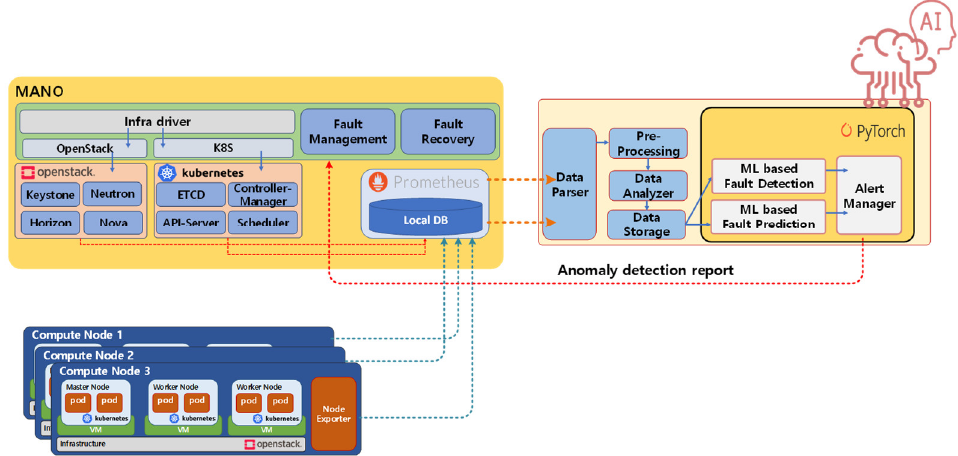
Figure 1. Proposed Architecture for ML based Fault Prediction Model.